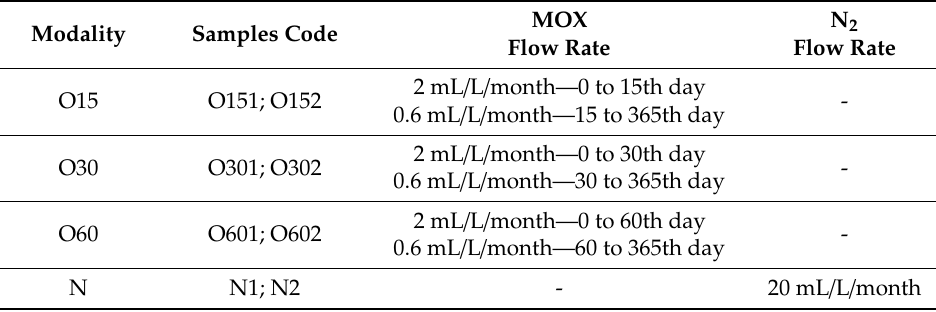
Table 5. Ageing modalities